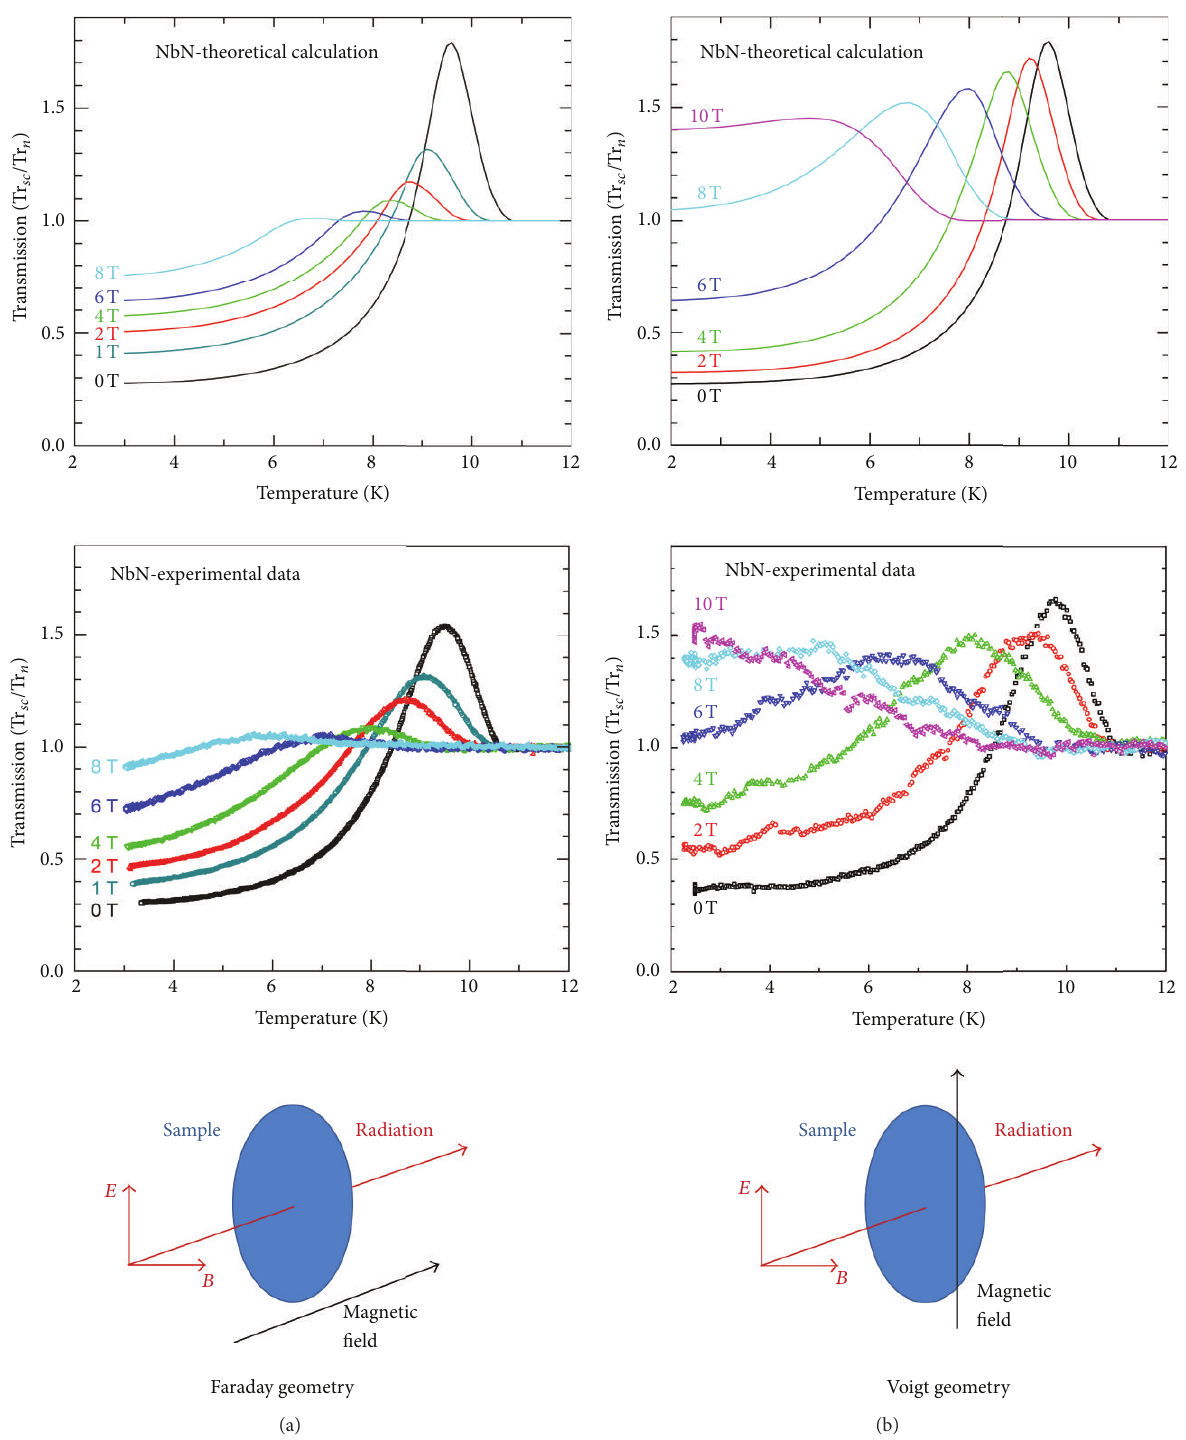
Figure 11: Temperature-dependent normal-incidence transmission of 13.5 cm −1 radiation through a 80nm NbN film on a Si substrate of 0.25 mm thickness. The orientation is either in Faraday geometry ( 𝐵 0 ⊥ 𝐸 ), shown in the left column, or in Voigt geometry ( 𝐵 0 || 𝐸 ) as shown in the right column. The calculations are done using a phenomenological effective medium approach (after